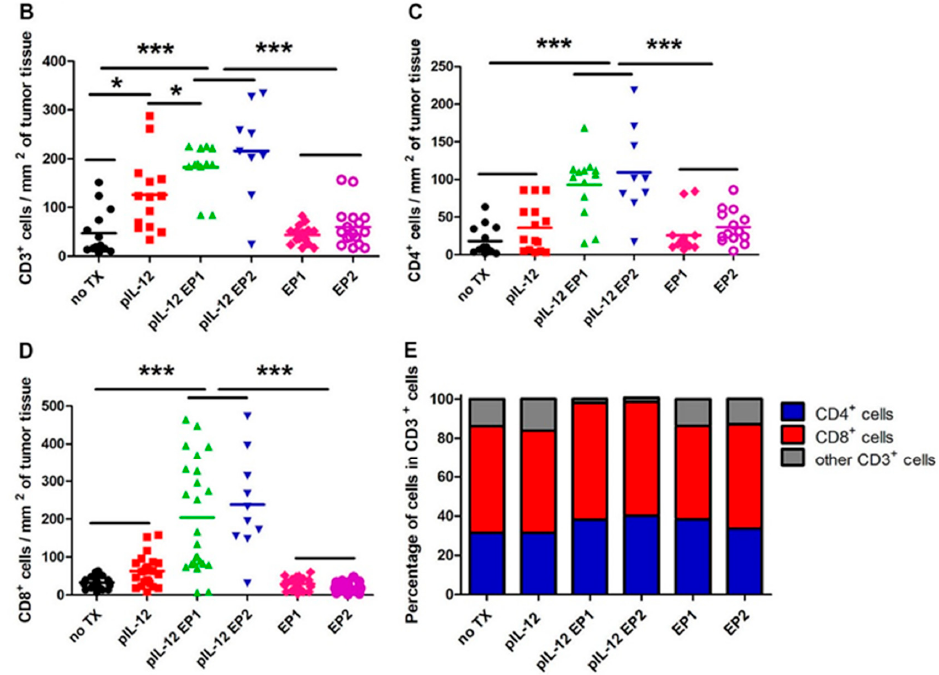
Figure 3. pIL-12 GET enhances tumor infiltrating lymphocyte (TILs) density in the Tumor Microenvironment. ( A ) Tumors were collected on day 9 for histological analysis. Paraffin sections of tumor tissue were stained with anti-CD3, anti-CD4 and anti-CD8. Visualized by optical microscope (×200). ( B – D ) Representative immunohistochemical analysis of pIL-12 GET. The density of TILs was quantified in 10–20 random fields (number of total cells > 200). Horizontal bars indicate mean values. The data presented are representative of two independent experiments. ( B ) CD3 + density. ( C, D ) IHC data represented as the mean density of CD4 + and CD8 + . ( E ) The percentage of CD4 + and CD8 + cells among total CD3 + cells. Each value represents the mean +/ − SEM of the group. Pooled data from two independent experiments are shown. One-way ANOVA, p * < 0.05, p ***< 0.001.